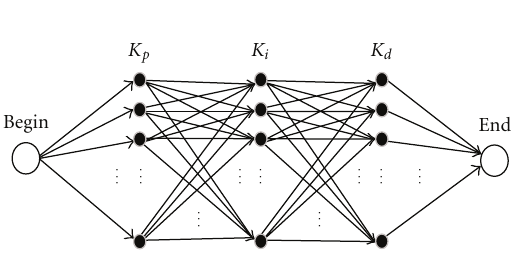
Figure 1: PID control system.